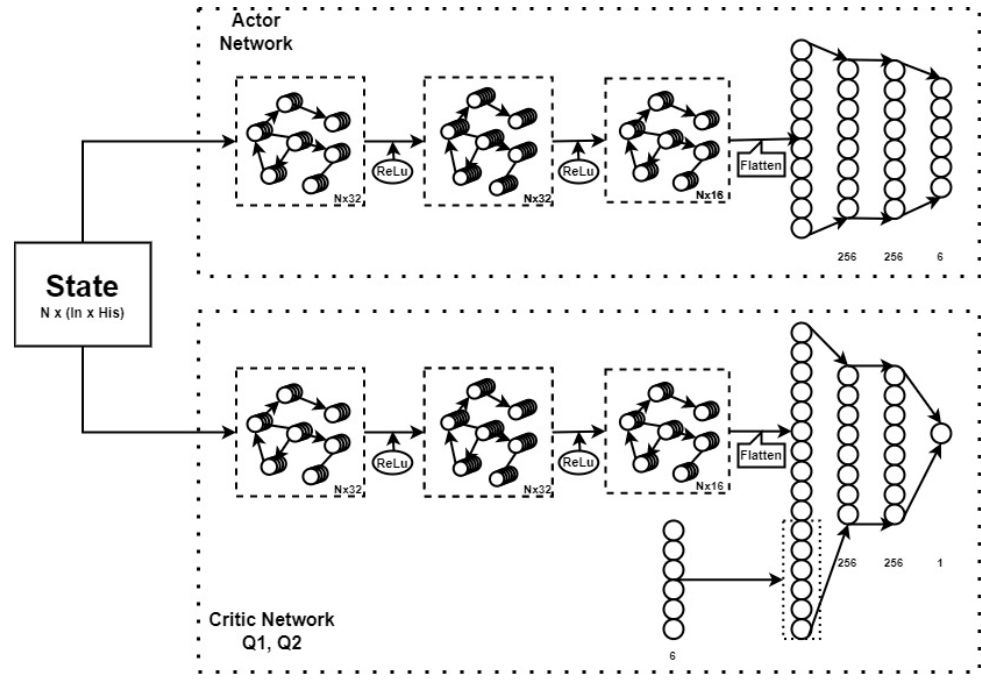
Figure 3. The actor network and two critic networks structure in GCTD3 algorithm: N is the number of nodes in the graph; “In” is the number of features of each node at a state; and “His” is the number of most recent consecutive states used during training, the activation function is ReLu.